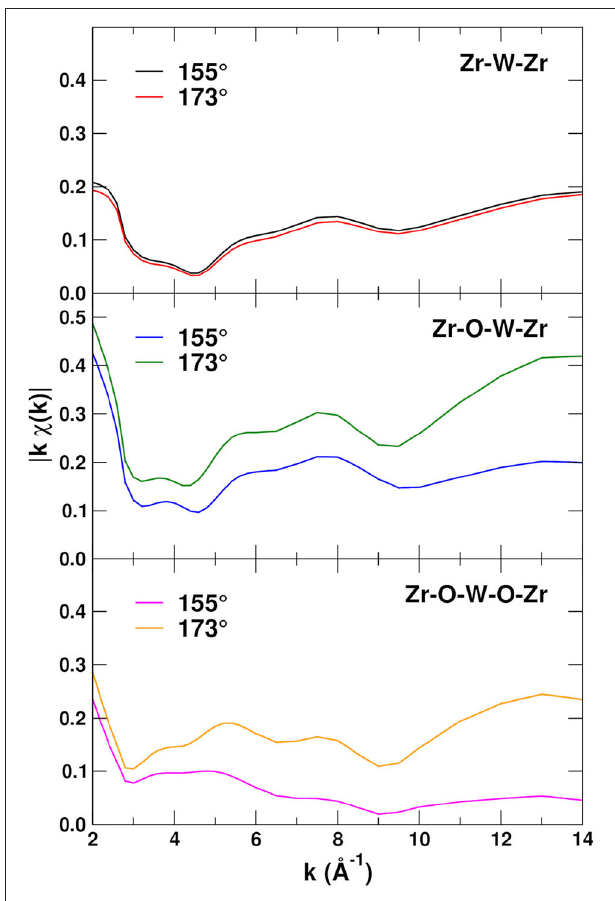
k χ p ( k ) for the Zr-W-Zr single-scattering | ˜ |